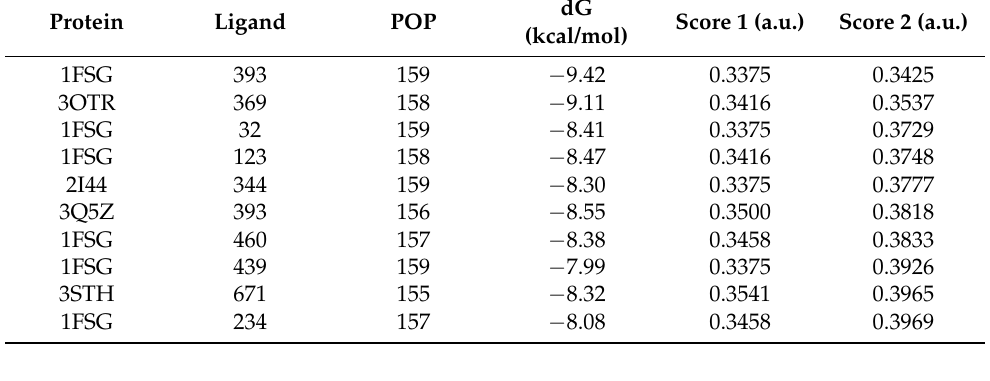
Table 1. Top ten protein–ligand complexes from the virtual screening of the 1018 compounds of